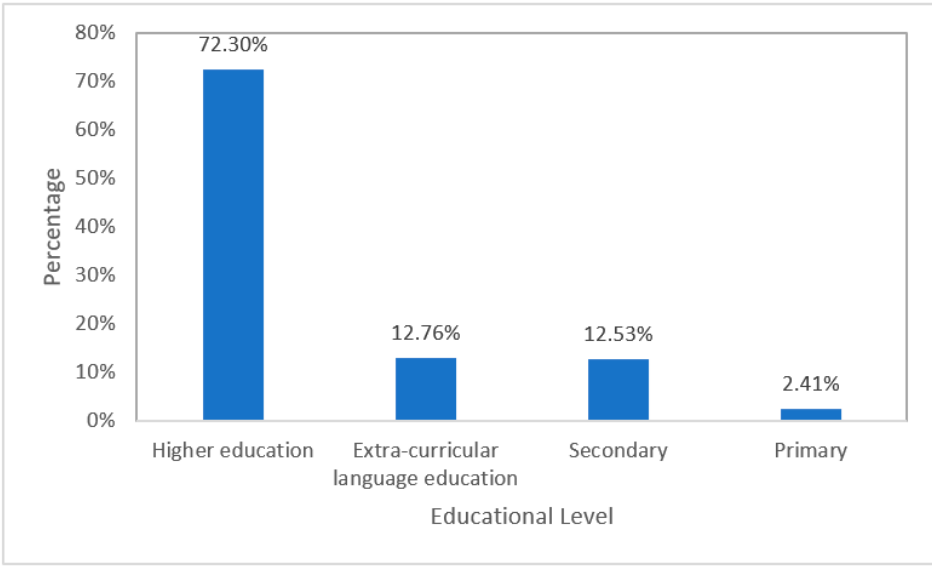
Figure 13. Educational level.